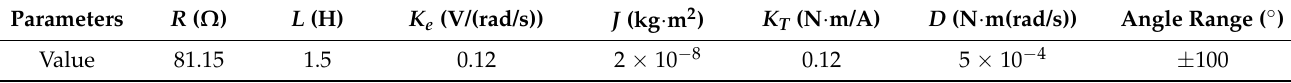
Table 1. Parameters of 38LXJ01-Z limited-angle torque